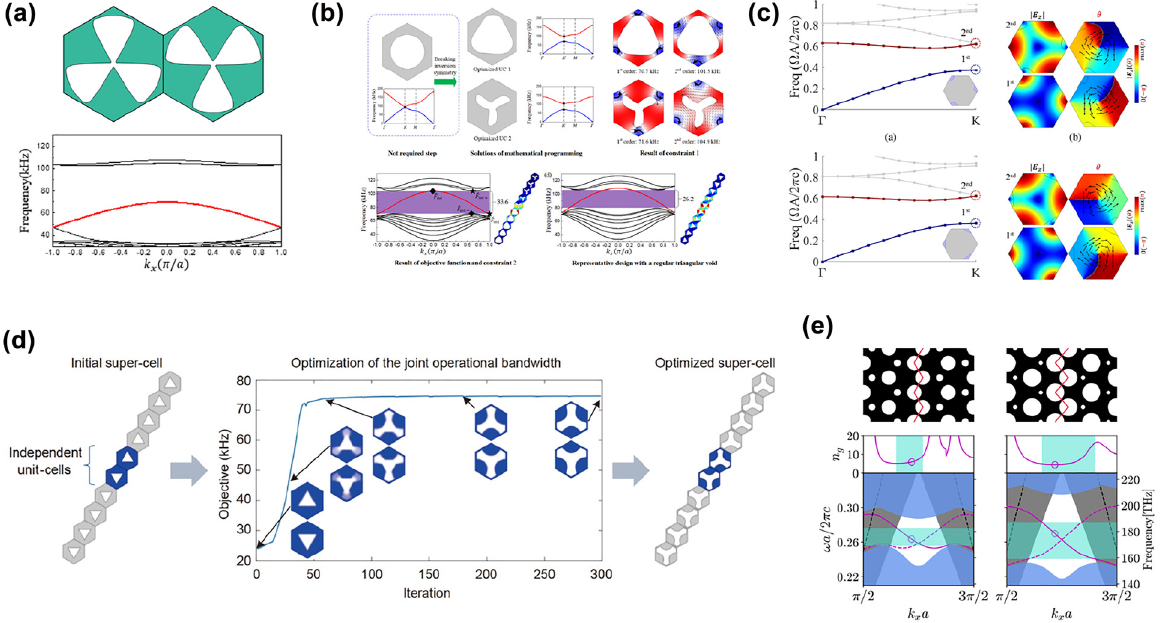
Figure 3: Inverse-designed photonic and phononic TIs based on QVHE. (a) Optimized unit cells for constructing QVHE-based phononic TIs using the first strategy in Ref. [107] and the dispersion diagram of the topological edge states. (b) Optimized unit cells using the second strategy in Ref. [107] and the dispersion diagram of the topological edge states. (c) Optimized unit cells for constructing QVHE-based photonic TIs in Ref. [102]. (d) Optimized supercells for constructing QVHE-based phononic TIs in Ref. [108]. (e) Initial (left panel) and optimized (right panel) QVHE-based topological photonic slabs in Ref. [109] and their dispersion diagrams of the corresponding topological edge